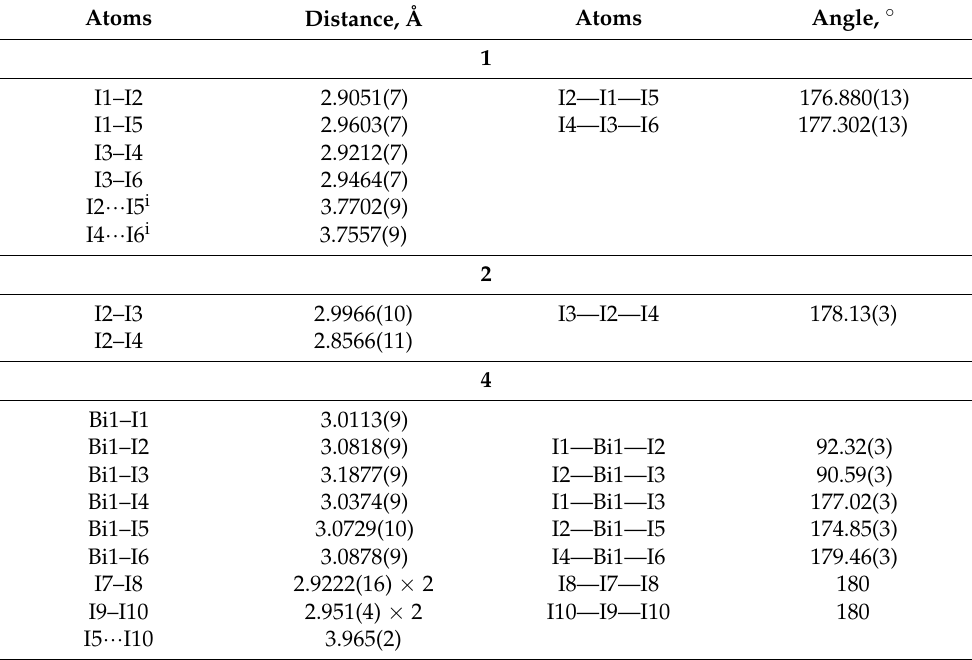
Table 1. Selected Interatomic Distances and Angles in the Anionic Part of the Crystal Structures of 1 , 2 , and 4 .